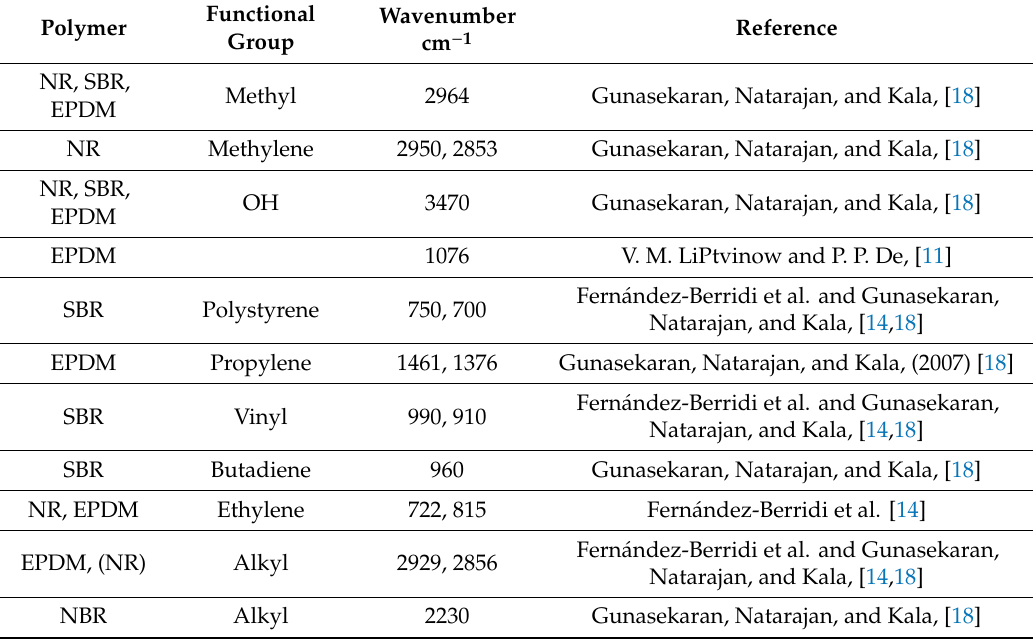
Table 2. Tire rubber material identification wavenumber cm − 1 . Polymers: NR = Natural Rubber,